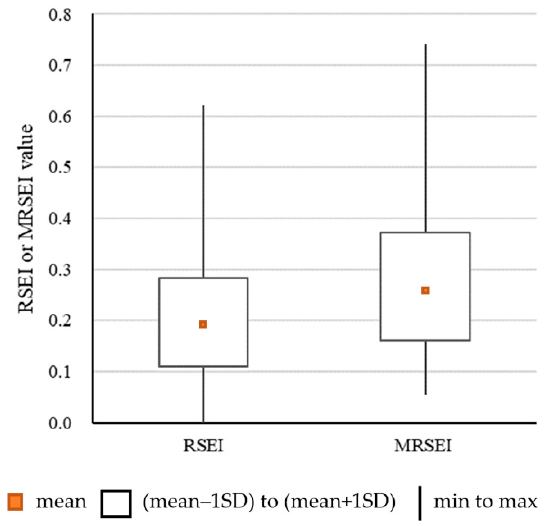
Figure 5. Box plot depicting the data distributions of RSEI and